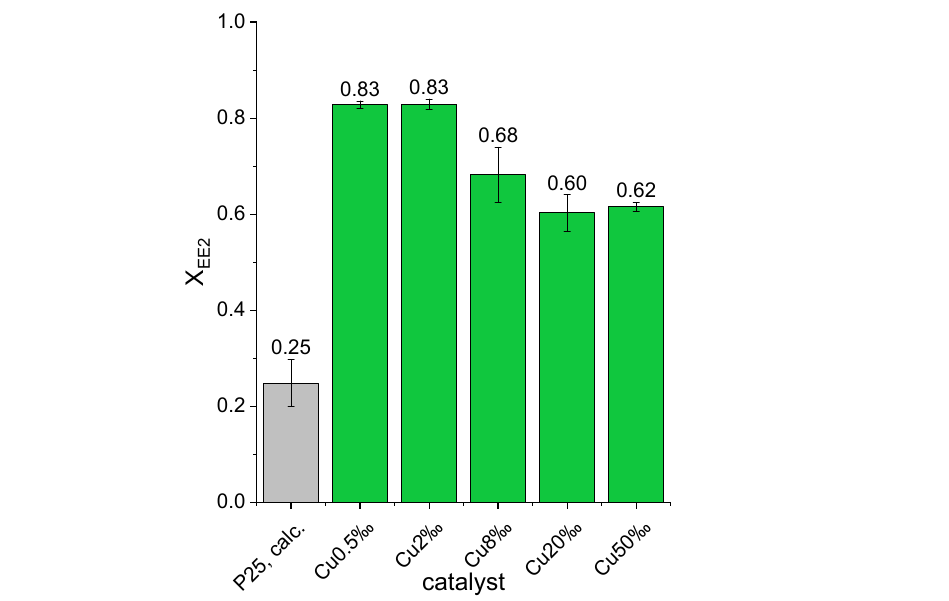
Figure 12. Screening of copper-doped P25 catalysts with different doping degrees. The experiment was carried out with a 60-fold parallel stirring UV-A LED photoreactor system [29]. Each value resembles a separate catalytic experiment, triple determination; reactant: EE2 (17 α -ethinyl estradiol), V = 5 mL, c start = 4.5 mg L − 1 ; catalysts: P25, calcination: t = 2 h, ϑ = 500 ◦ C, m P25 = 7.5 mg; CuX ‰, P25 catalyst impregnated with copper acetate solution in pure water (c(Cu(OAc) 2 ) = 8.6 mmol L − 1 , x Cu = n Cu n Ti − 1 = 0.5, 2, 8, 20, 50‰), calcination: t = 2 h, ϑ = 500 ◦ C; reaction: f rot = 800 min − 1 , t dark = 30 min, t irradiation = 1.5 min, E = 384 mW cm − 2 , λ = 365 nm; EE2 content determination by SPE-GC-MS analysis (determination of ion count n as measure for the amount of substance from the extracted ion current (EIC), precursor ions: [M] + 440 m / z , [M-15] + 425 m / z ).